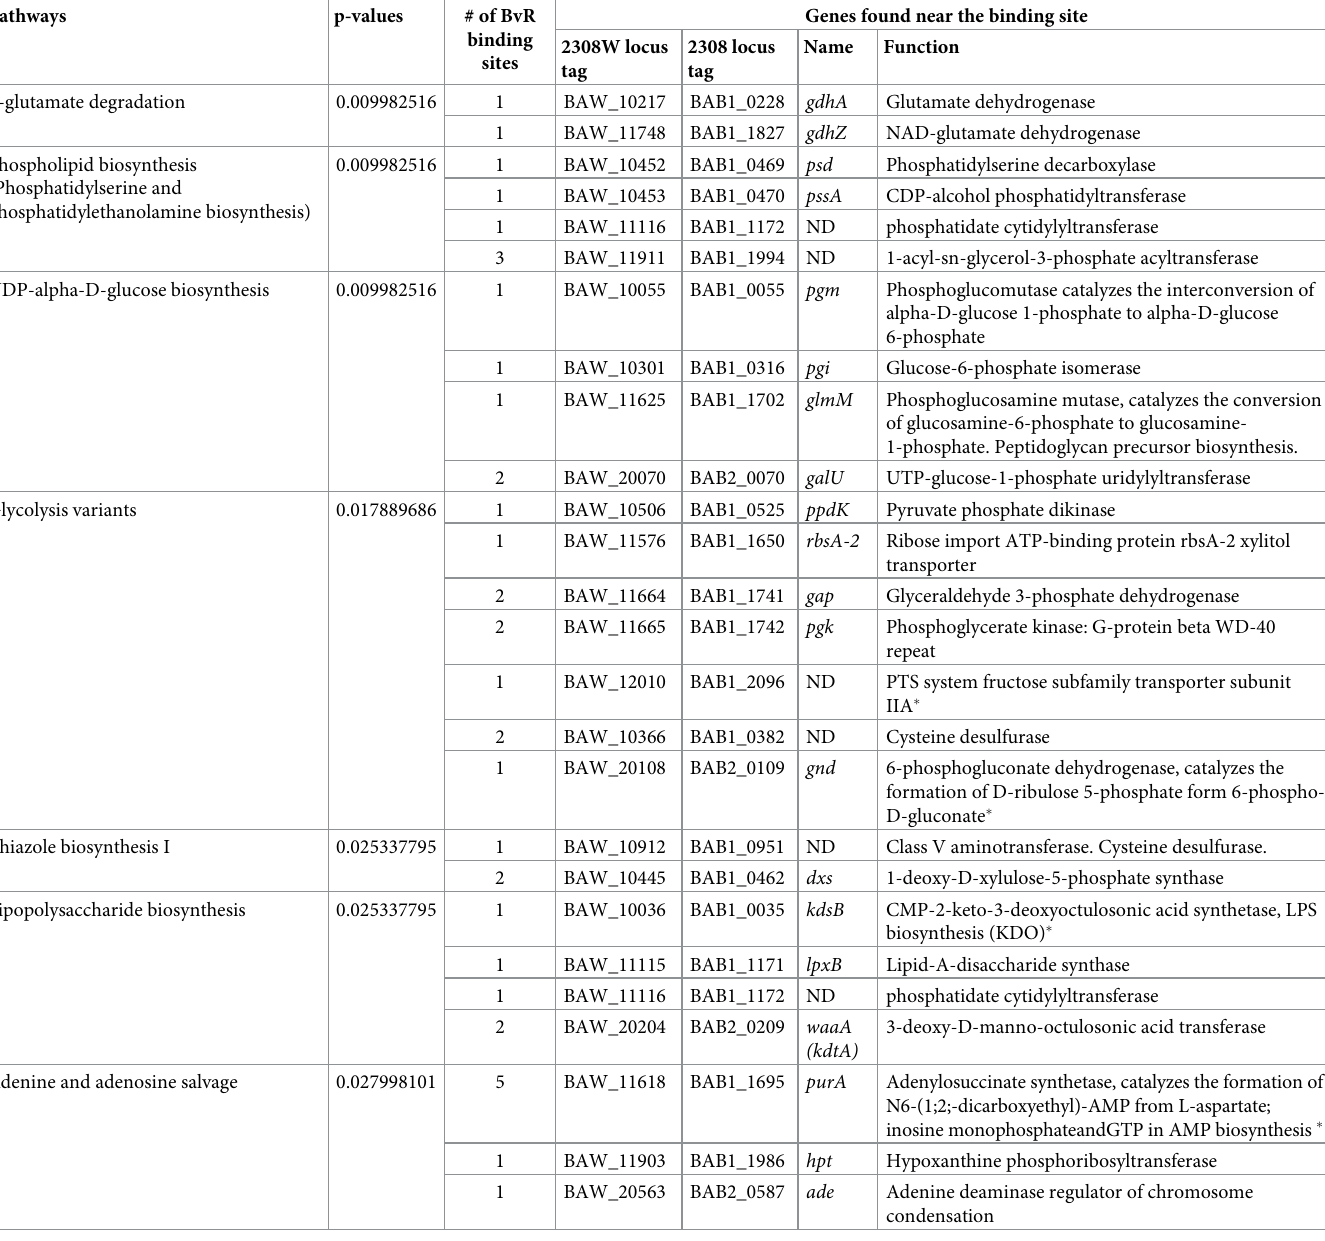
Table 2. Manually curated Biocyc enrichment analysis of metabolic pathways found in the BvrR ChIP-Seq under stress conditions.